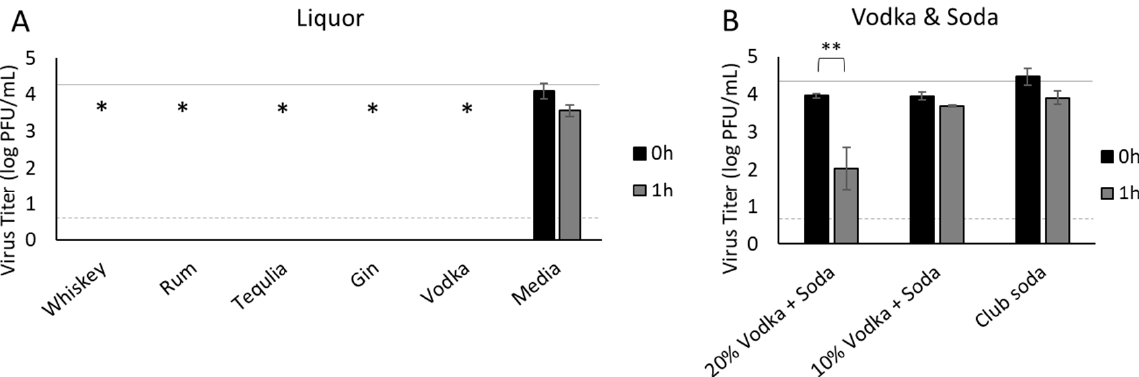
Figure 5. Survival of SARS-CoV-2 in liquor. SARS-CoV-2 was recovered from liquors ( A ) and mixed beverages consisting of vodka and club soda to different alcohol percentages ( B ) immediately after inoculation (0 h) and 1 h later, quantified by plaque assay on Vero E6 cells and shown as log PFU/mL. Infectious virus was significantly reduced immediately after inoculation (0 h) in liquors ( p < 0.0001). The inoculum is shown as a solid gray line (4.3 log PFU/mL) and the detection limit of the plaque assay is shown as a dashed line (0.7 log PFU/mL). Significant differences between 0 h and inoculum are shown with an asterisk. Significant differences between means at 0 h and 1 h are shown by brackets and asterisks (* <0.05; ** <0.01). Error bars = SEM.